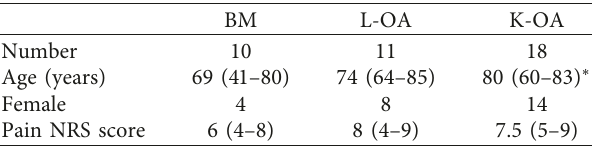
Figure 1: The pictures show the corresponding ultrasonic irradiation pathways on the MRI monitor. The blue area represents the ultrasonic irradiation route, and the green circle is the target site for each disease. (a) Irradiation for painful bone metastasis of the ilium. The green circle shows the part with maximal tenderness over the bone metastasis site in the ilium. (b) Irradiation for lumbar facet joint osteoarthritis. The green circle shows the dorsal area of the painful lumbar facet joint. (c) Irradiation for knee osteoarthritis. The green circle shows the bone surface around osteophytes in the medial tibiofemoral joint. (d) Schematic diagram of the pathway of the ultrasonic irradiation to the bony lesion. Table 1: Baseline characteristics of patients in the three study